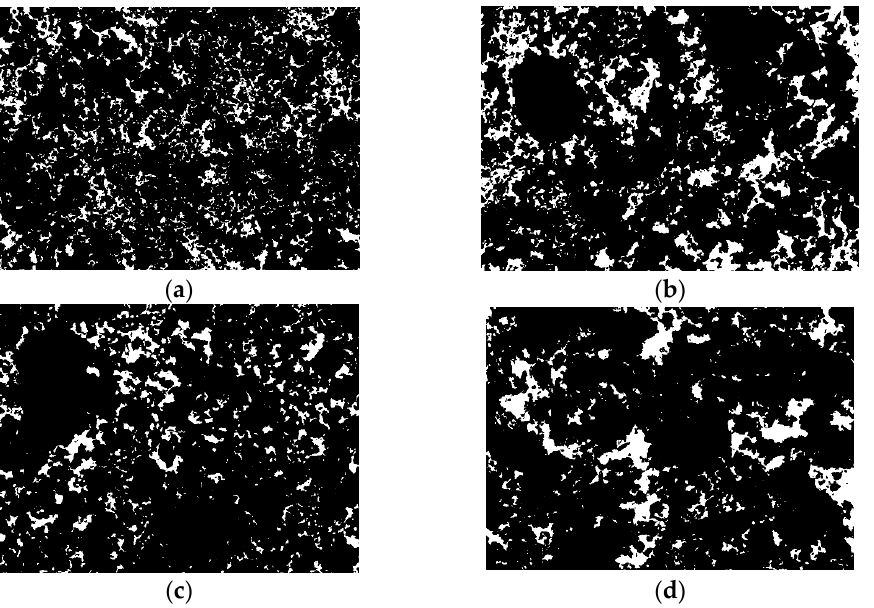
Figure 13. Black and white binary images of the specimens at 28 d of curing time: ( a ) RLC1-28 with 0 time; ( b ) RLC1-28 with 10 times; ( c ) RLC5-28 with 0 time; ( d ) RLC1-28 with 10 times.